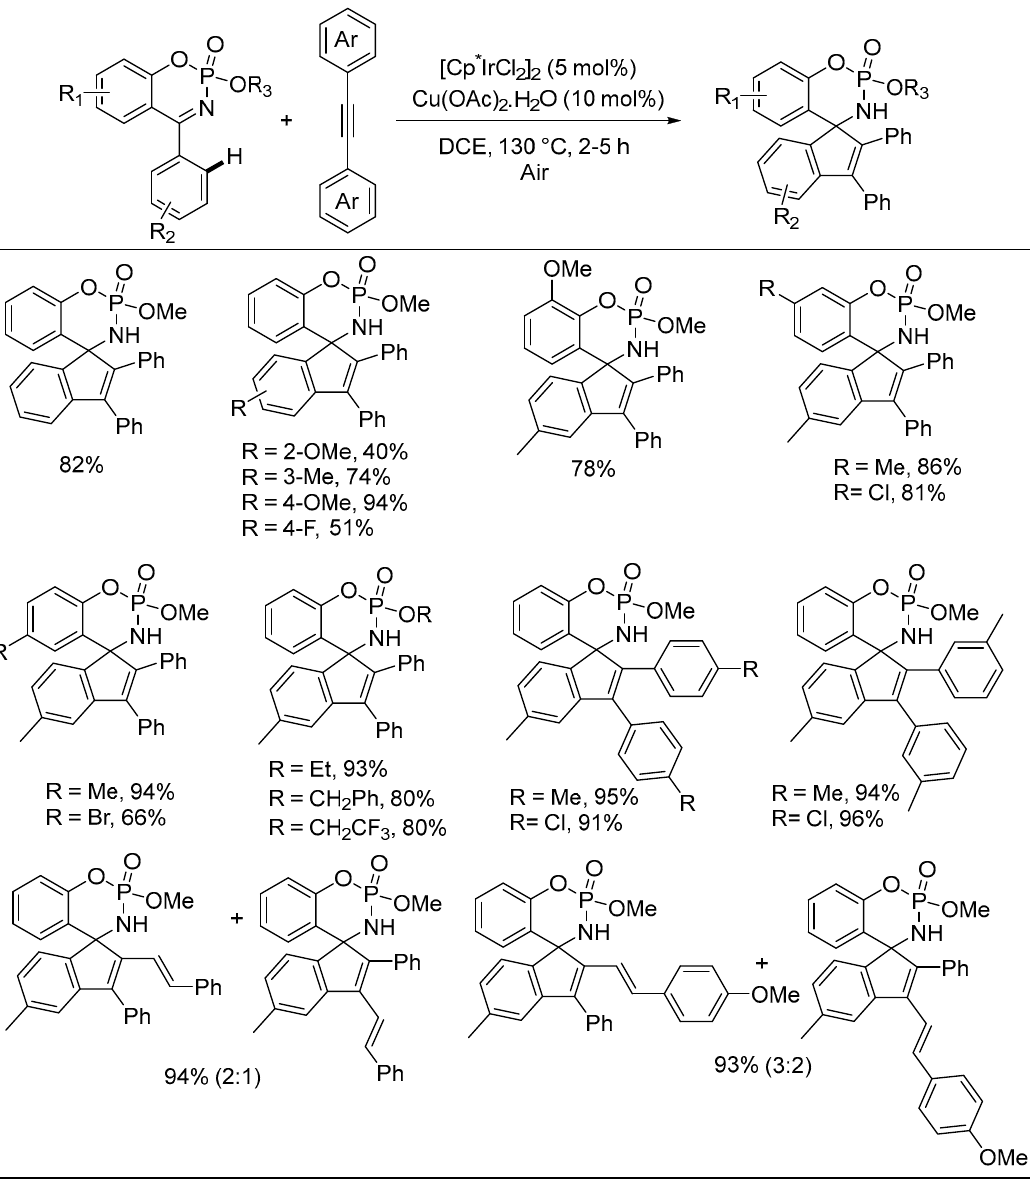
Scheme 20. Ir-catalyzed synthesis of spirocyclic